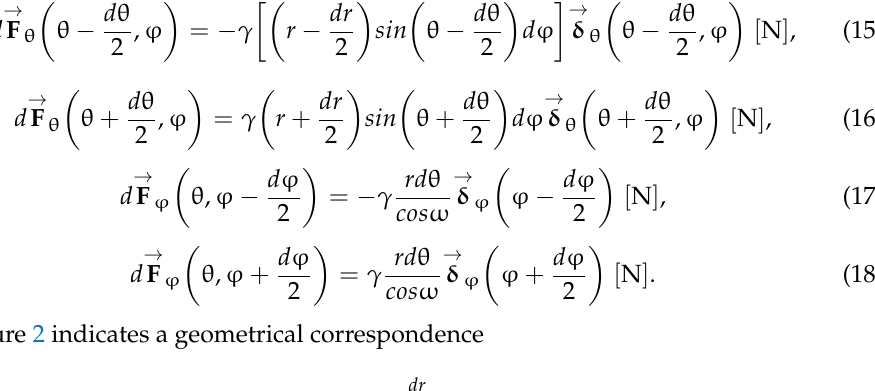
Figure 2 indicates a geometrical